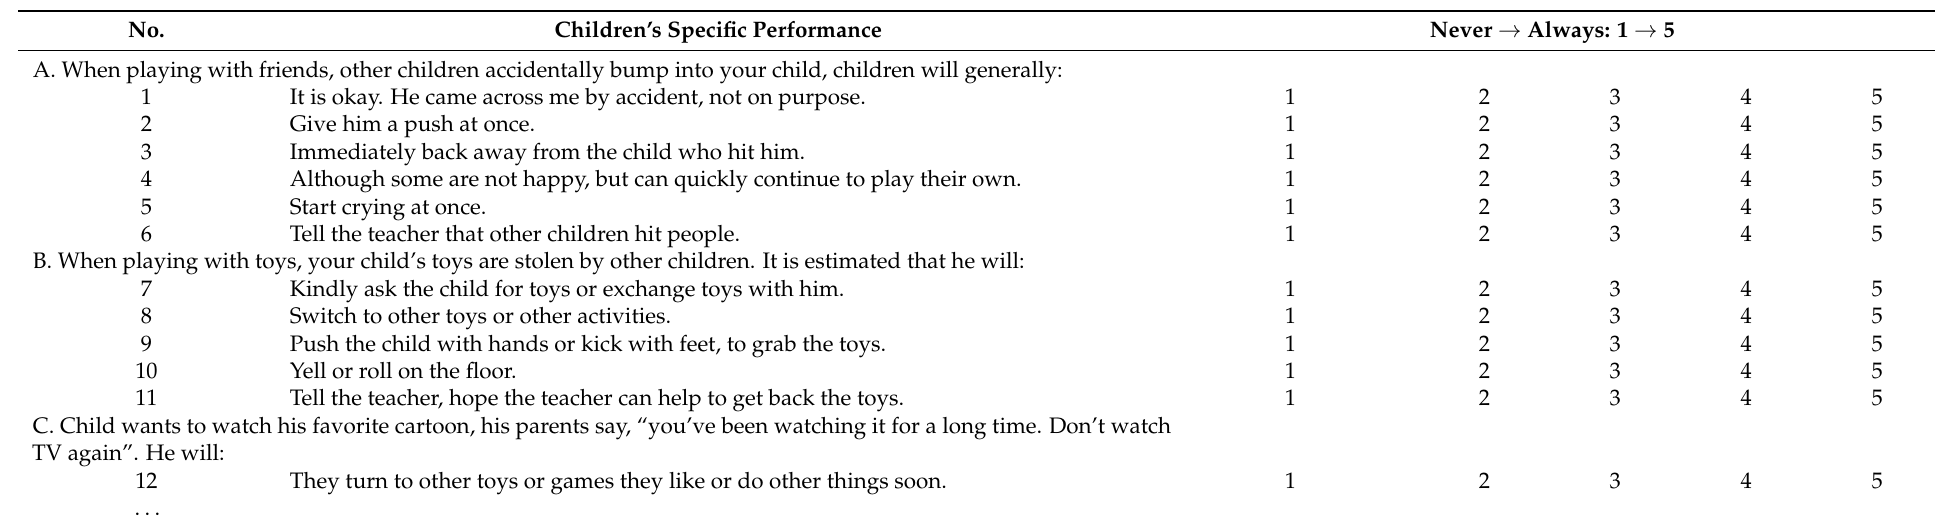
Table A2. Children’s emotional regulation questionnaire (for